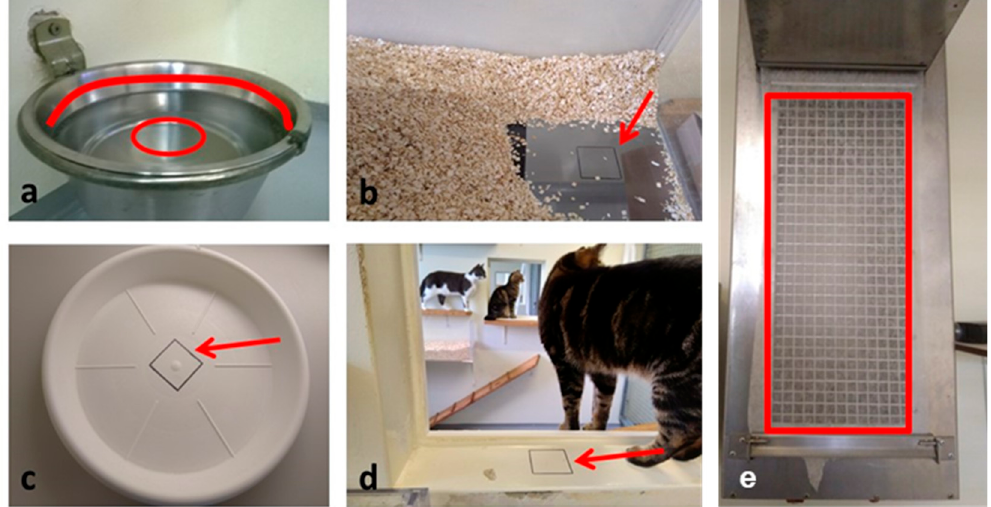
Figure 2. Collection of environmental samples to test for FCV contamination in the cat rooms. ( a ) Water bowl: Four cotton swabs were humidified with sterile phosphate buffered saline (PBS) and rolled over the area above the water level (red line). Four cotton swabs were soaked with the water from the bowl without pre-humidification (red circle). ( b ) Litter tray: Four cotton swabs were humidified with sterile PBS and rolled over the 6 × 6 cm 2 marked area (red arrow). Two identical litter trays were available for the cats in the facility, and both of them were tested. ( c ) Food bowl: Four cotton swabs were humidified with sterile PBS and rolled over the 6 × 6 cm 2 marked area (red arrow). Two food bowls were used to serve dry food in the afternoon, the empty bowls were left